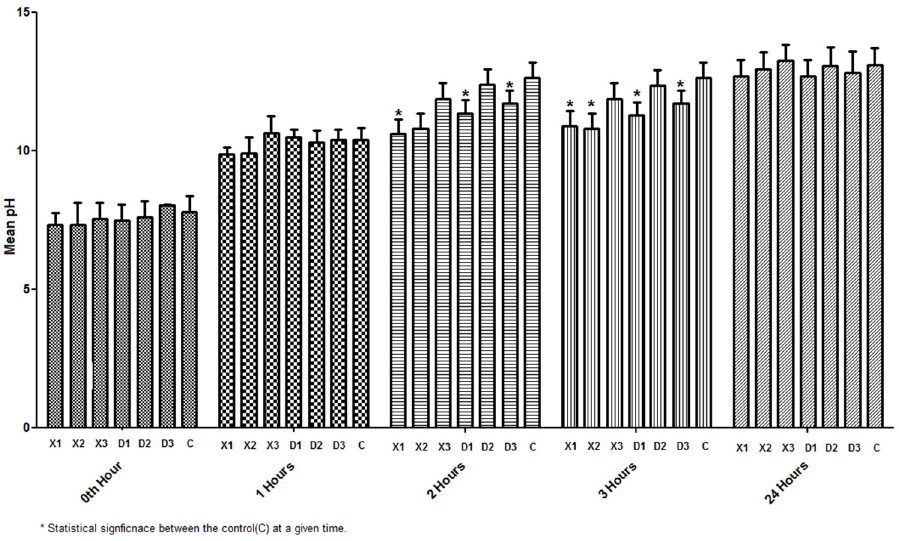
Figure 6. Physiomechanical property assessment based on alkalinity from 0 to 24 h.